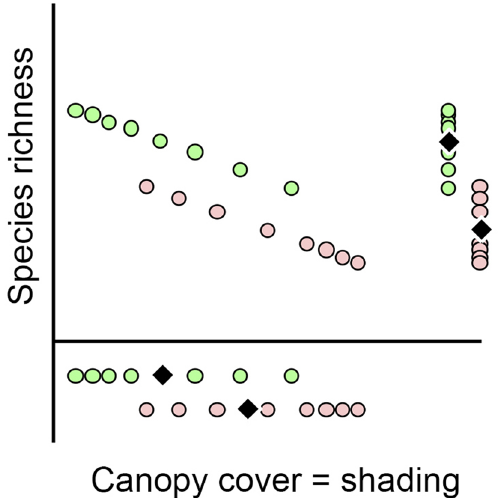
Figure 9. A probable mechanism of the generation of reduced diversity of the ground cover throughout canopy shading in communities dominated by Acer negundo (pink circles) in comparison with other trees (green circles); rhombus—average